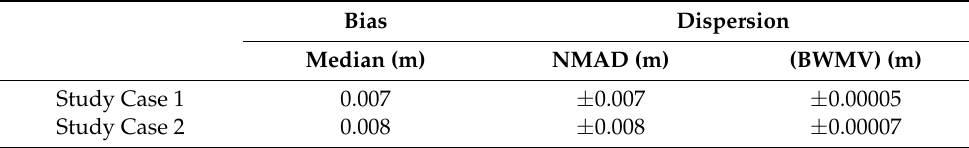
Table 3. Bias and dispersion results of the TLS vs. BIM for the two study cases. Bias